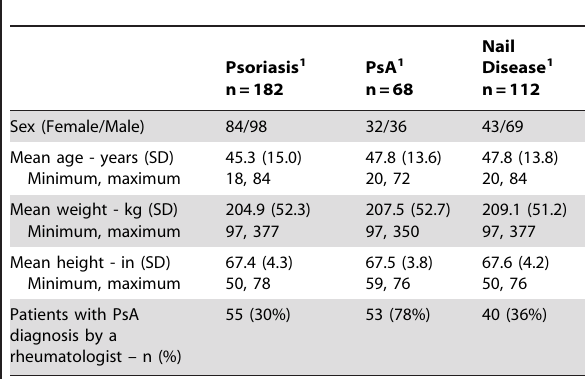
Table 1. Patient demographics at